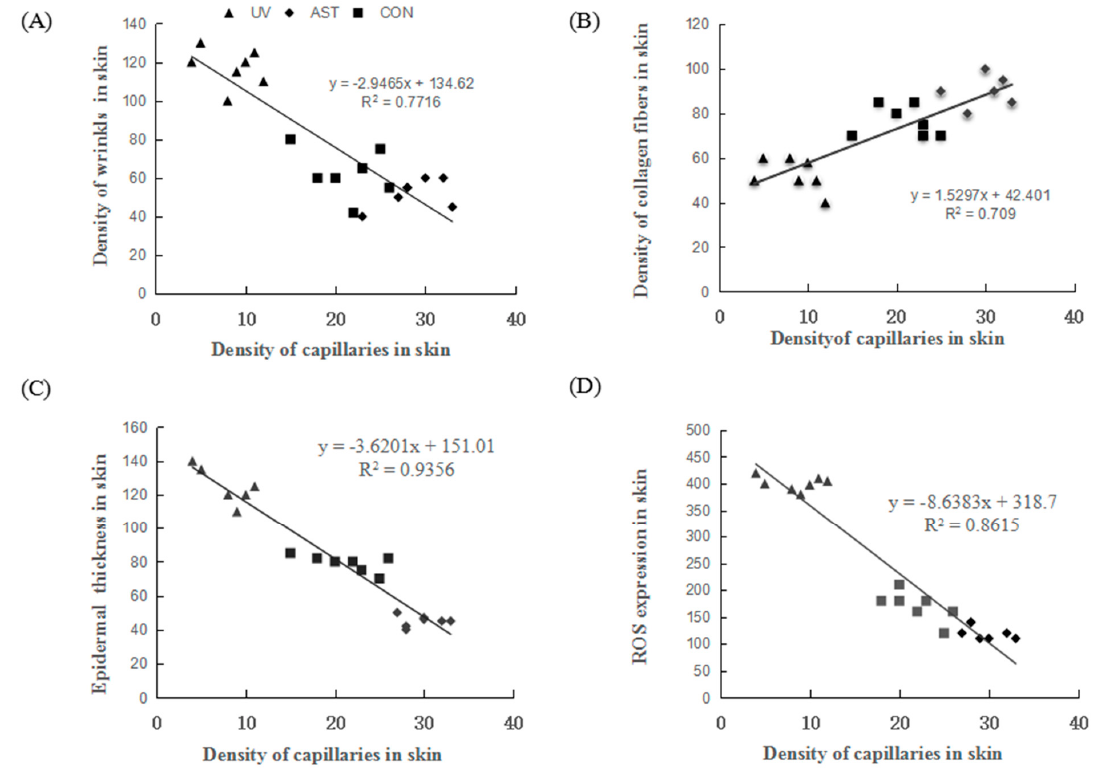
Figure 6. The correlation between the density of capillaries and density of wrinkles, density of collagen fiber, epidermal thickness, and ROS expression in the dorsal skin of ultraviolet (UV)-induced mice. ( A ) The density of capillaries is negatively correlated with the density of wrinkles. ( B ) The density of capillaries is positively correlated with the density of collagen fibers. ( C ) The density of capillaries is negatively correlated with the thickness of the epidermis. ( D ) The density of capillaries is negatively correlated with the reactive oxygen species (ROS) expression.